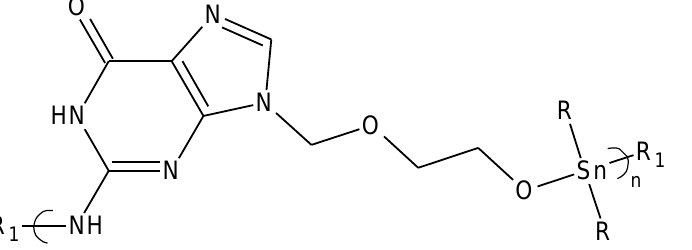
Figure 8. Repeat unit for the product derived from reaction of acyclovir with organotin